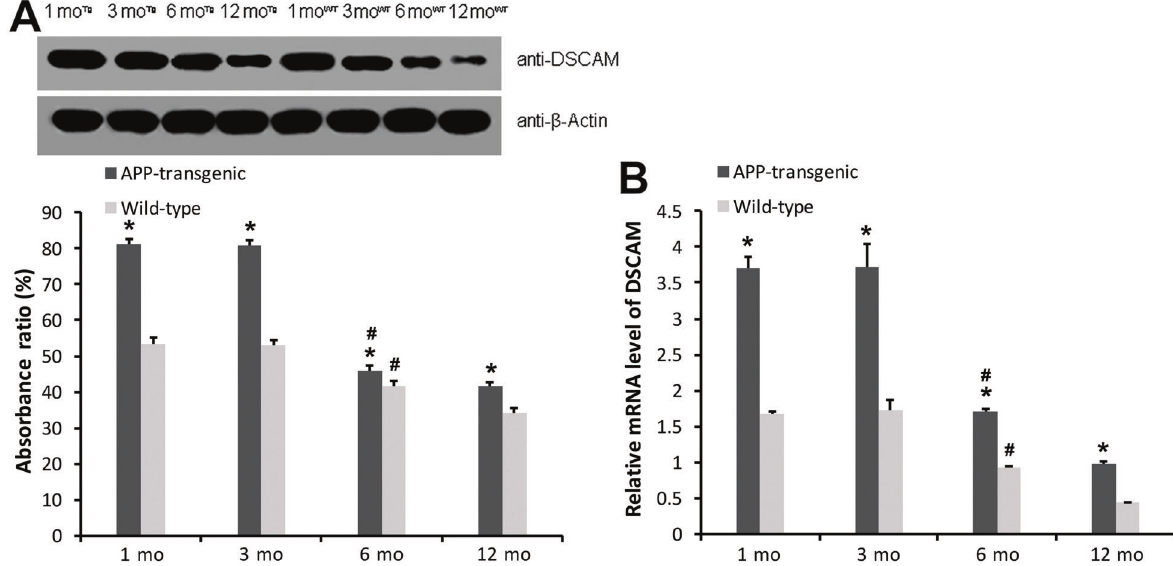
Figure 3. Expression of Down syndrome cell adhesion molecule (DSCAM) mRNA and protein in hippocampus of mice in different groups. DSCAM expression was measured by western blot ( A ) and qRT-PCR ( B ) in hippocampal lysates from amyloid precursor protein (APP) transgenic (Tg) and wild-type (WT) mice (1, 3, 6, and 12 months [mo] old). *P o 0.05 vs the age-matched WT group; # P o 0.05 vs 3- and 12-mo mice of the same genome type (n=10) (ANOVA followed by least signi fi cant difference t -tests for pair-wise